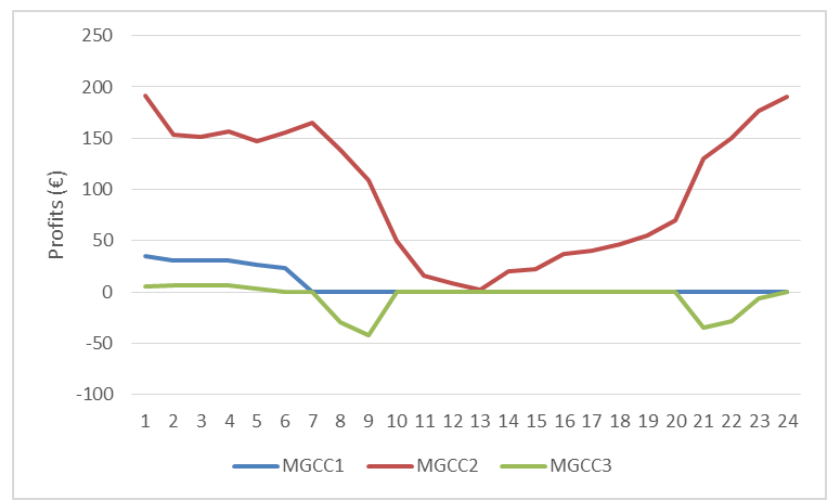
Figure 7. Profits achieved by the three MGCC in the third level of negotiations.